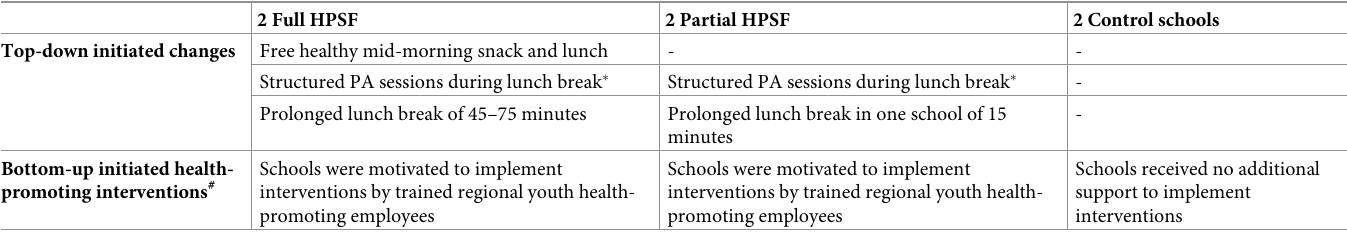
Table 1. Interventions in the Healthy Primary School of the Future (HPSF). 2 Full